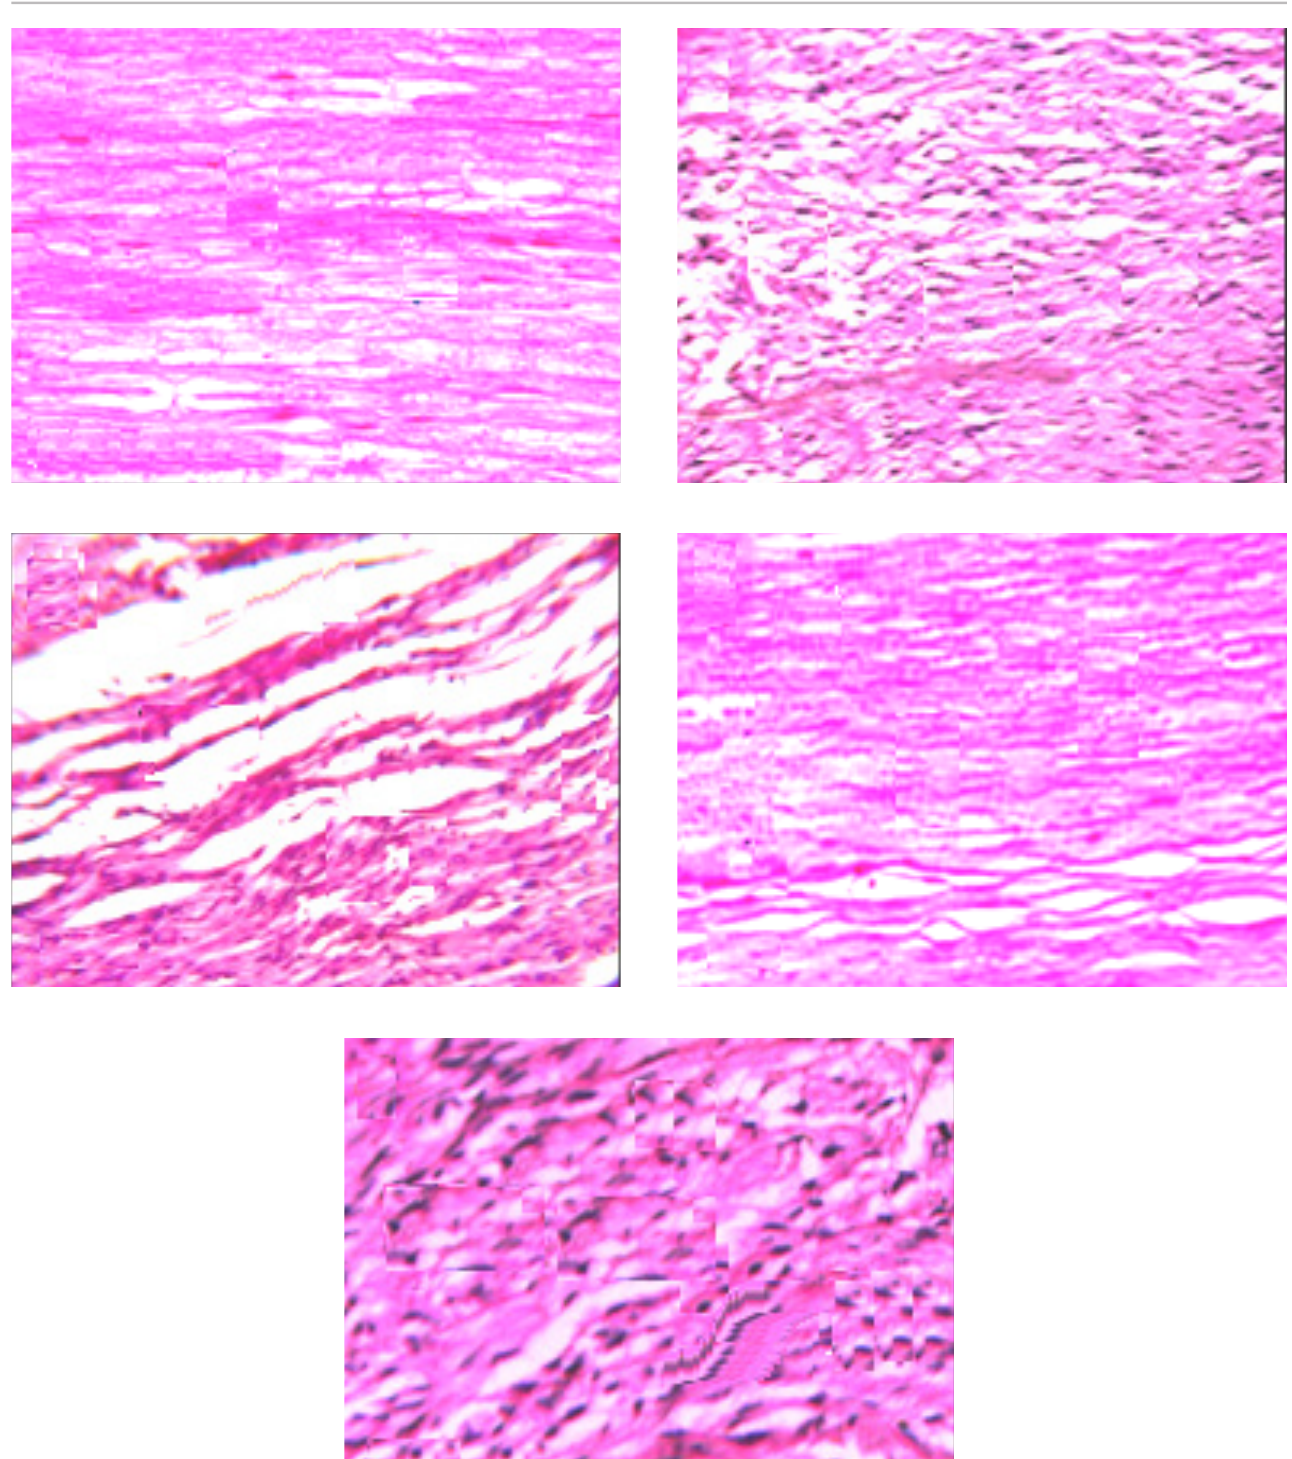
FIGURE 4(A– E)- Effect of trazodone on partial sciatic nerve ligation-induced histopathological